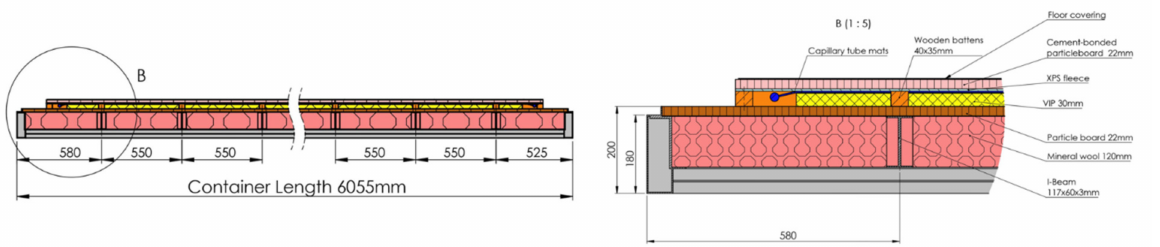
Figure 16. Construction of a multifunctional floor assembly.